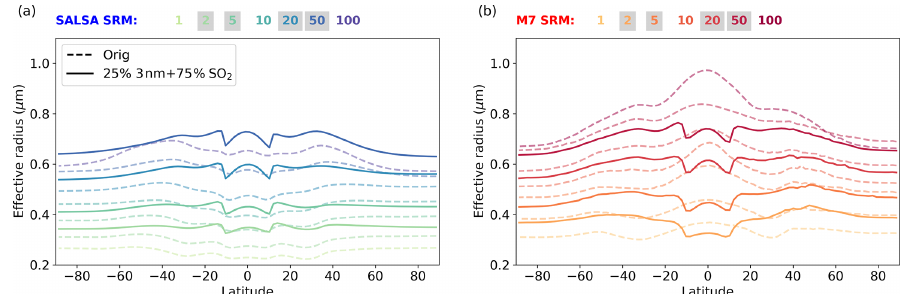
Figure A2. Zonal mean effective radius of stratospheric aerosols for different magnitudes of sulfur injections simulated with (a) SALSA and (b) M7. The lighter dashed lines correspond to the original simulations, and the darker solid lines represent the corresponding simulations without nucleation.